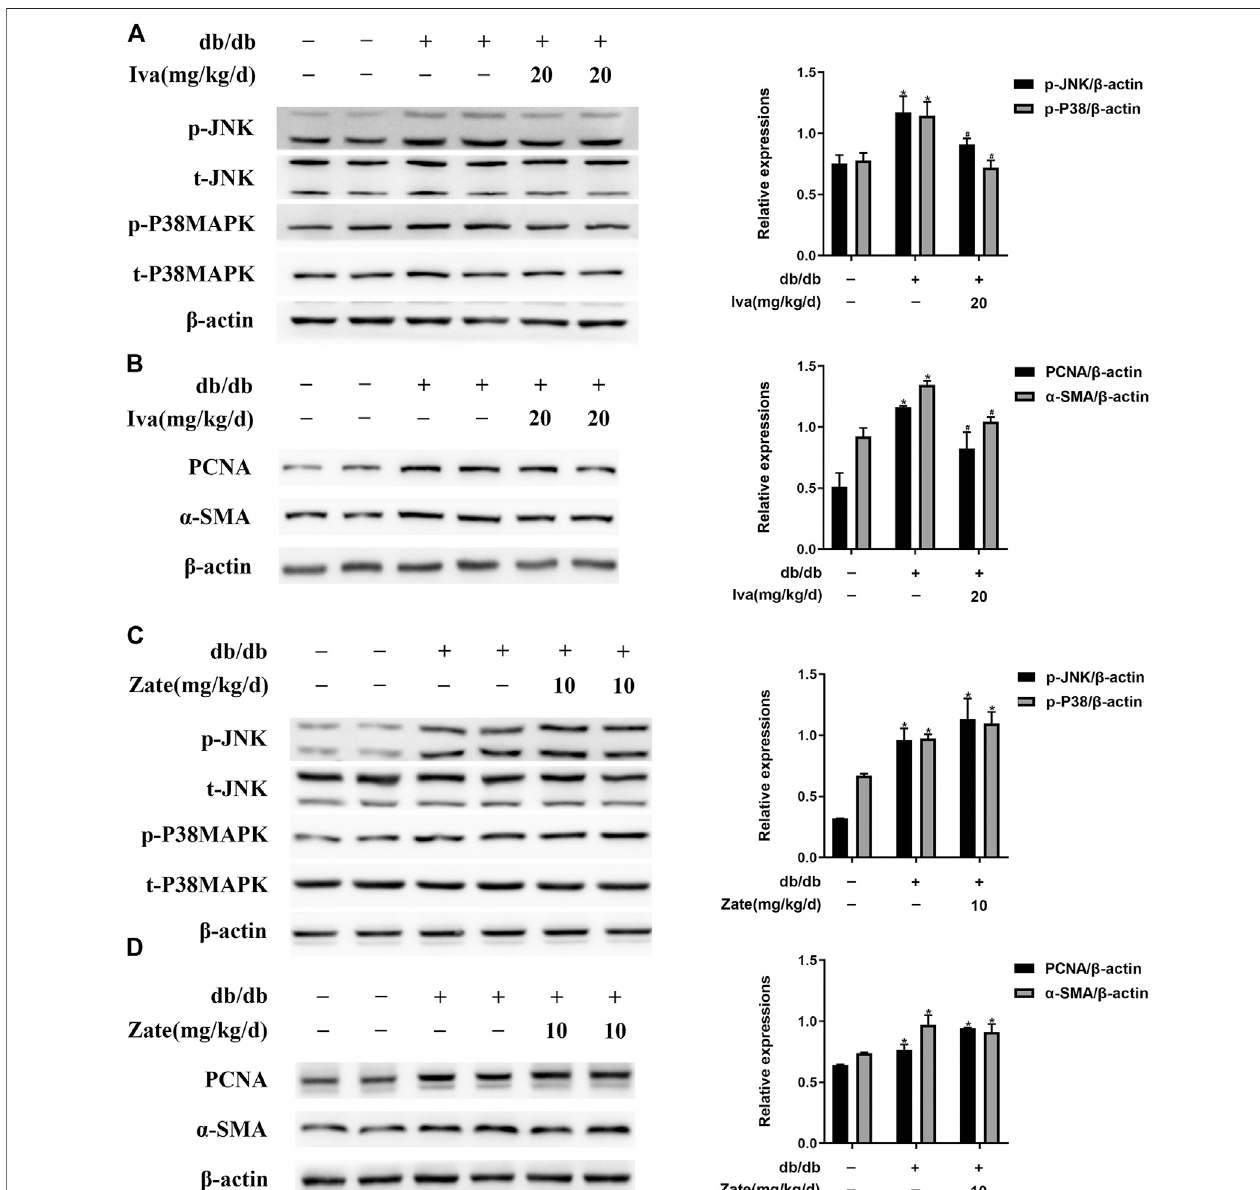
FIGURE 6 | Ivabradine reduces JNK and p38 MAPK activation and inhibits diabetes-induced CF proliferation and activation in vivo (A) Left ventricular fi broblasts isolated from mice treated with ivabradine at the indicated dose. JNK and p38 MAPK phosphorylation and total JNK and p38 MAPK expression were determined by western blotting (B) In CFs from mice treated as described in (A) , the expression of PCNA and α -SMA was determined by western blotting (C and D) In left ventricular fi broblasts isolated from mice treated with zatebradine at the indicated dose the expression of the proteins listed in (A) and (B) was measured by western blotting. Data are presented as mean ± SEM ( n (cid:2) 3). p -values were calculated using one-way ANOVA with Tukey multiple comparison test. * p < 0.05, compared to the Control group; # p < 0.05, compared to the db/db mice group.